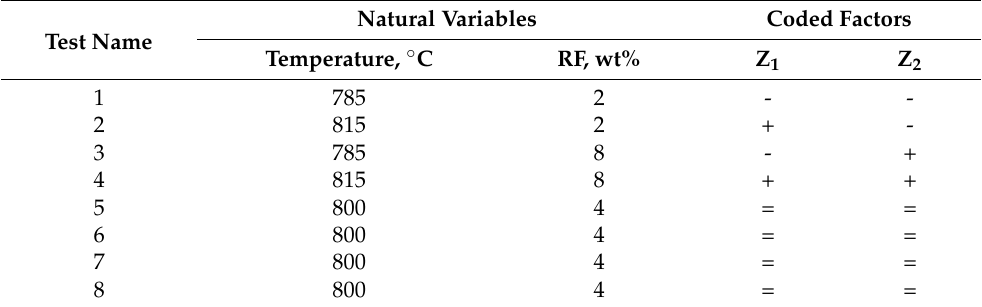
Table 4. The response surface methodology (RSM) plan for pyrolysis tests. Pyrolysis test conditions (variables: Temperature from 785 to 815 ◦ C and RF amount in the mixture from 2 to 8